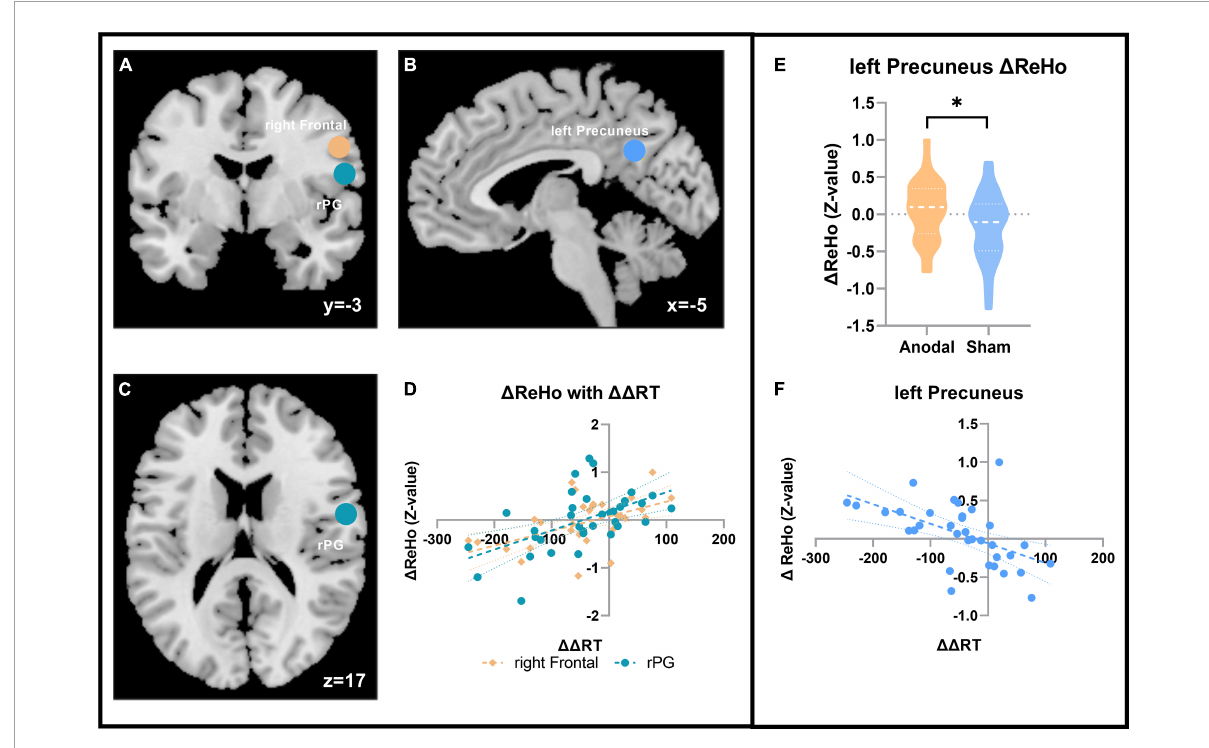
FIGURE4 ReHo with the distractor effect results. (A–C) The (cid:49) ReHo in the three ROI correlated with the (cid:49)(cid:49) RT in the two sessions in the anodal stage. (A) Coronal; (B) sagittal; and (C) axial. Blue, left precuneus; coffee color, right frontal; turquoise, rPG. (D) (cid:49)(cid:49) RT correlation result with the (cid:49) ReHo in the two regions. (E) (cid:49) ReHo result in the left precuneus. (F) Correlation result with (cid:49)(cid:49) RT in the left precuneus. ∗ p <